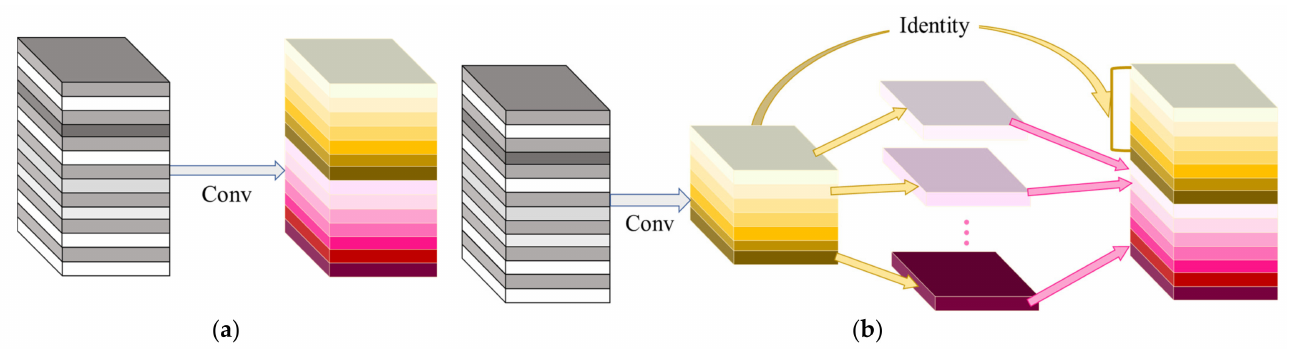
Figure 5. The feature extraction process of the model. ( a ) The convolutional layer. ( b ) The Ghost module. Since it is difficult for current Convolutional Neural Networks (CNNs) to take fea- tures from global features, channel attention (e.g., Squeeze Excitation (SE) attention) [31] has a significant effect on improving model performance. However, this method usu- ally ignores location information, which is important for generating spatially selective attention maps. CA [32] decomposes channel attention into two one-dimensional feature encoding processes, which aggregate features along two spatial directions